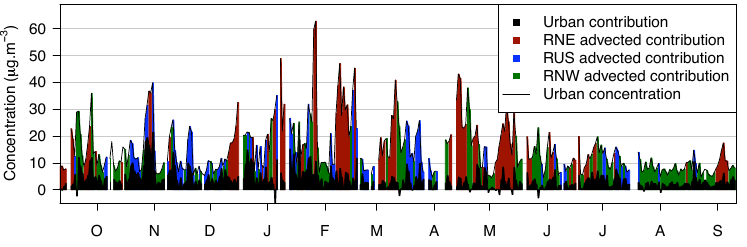
Figure 6. Imported and local contributions to the daily observed PM 2 . 5 concentrations in Paris (PAR). The urban local contribution is colored in black. Advected contributions are represented according to air mass origin in red (for northeast regime), blue (south) and green (northwest). Note that for several days, no chemical PM 2 . 5 speciation is available.